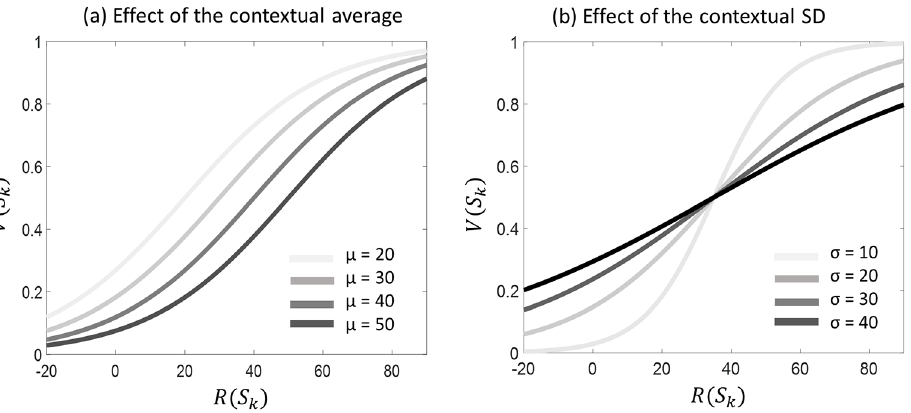
Note. (a) Predicted effect of average µ (σ = 20). (b) Predicted effect of SD σ (µ =